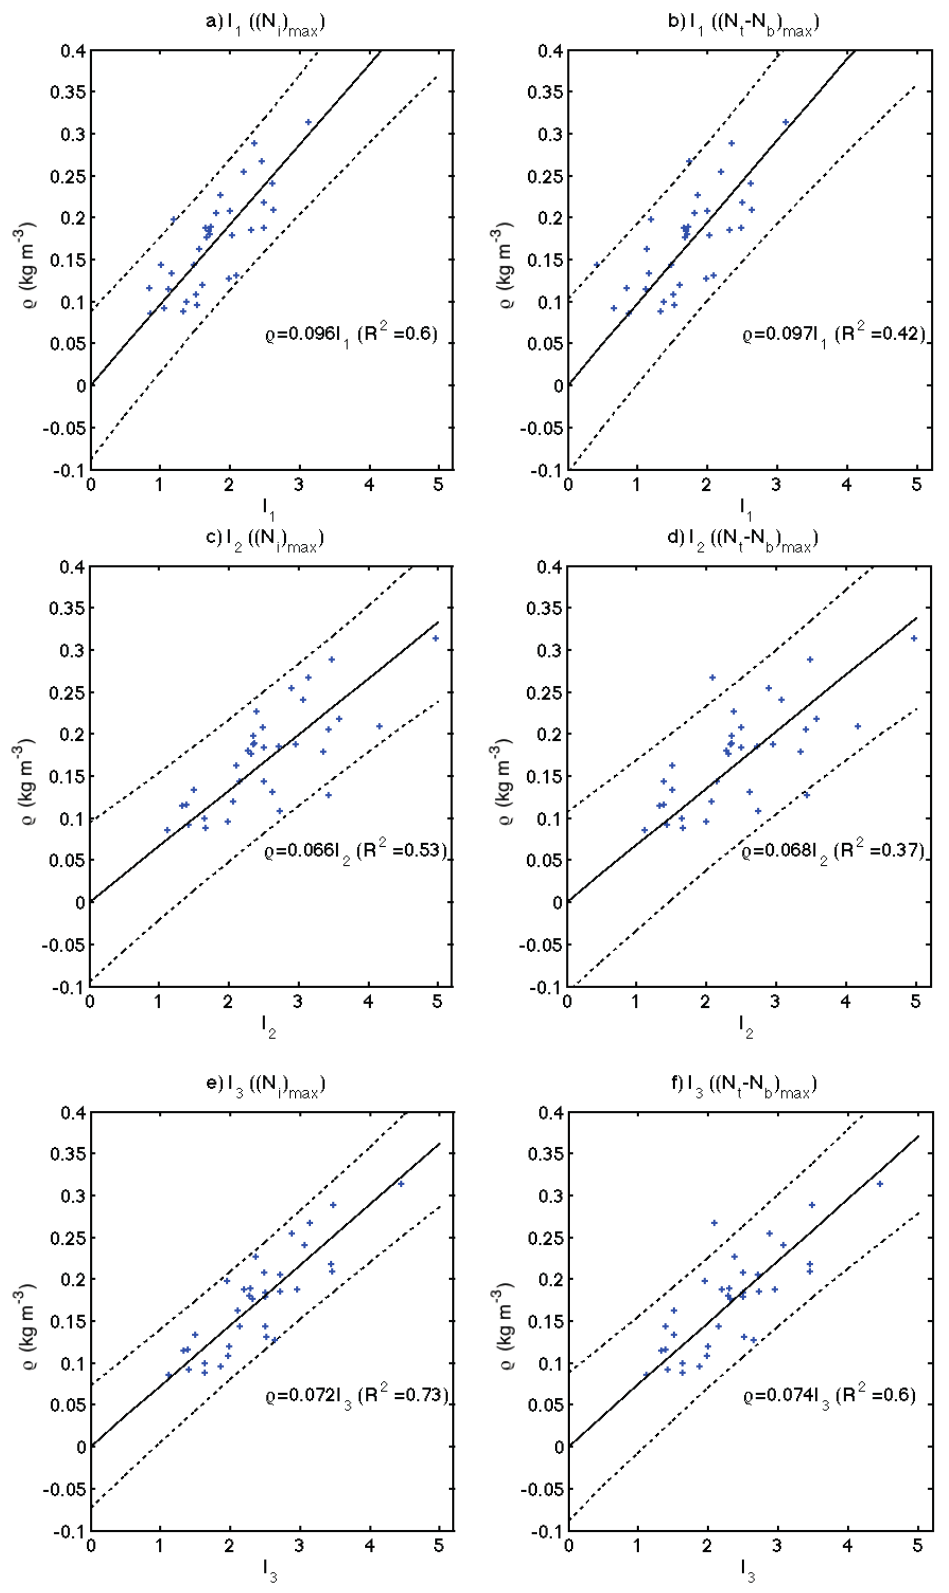
Figure 6. Calibration of indices I 1 , and I 2 , I 3 against leaf bulk densities in 35 CVs for the two scan selections, ( N i ) max and ( N t − N b ) max : ( a ) and ( b ) Index I 1 ; ( c ) and ( d ) Index I 2 ; and ( e ) and ( f ) Index I 3 . Dashed lines are 95% confidence